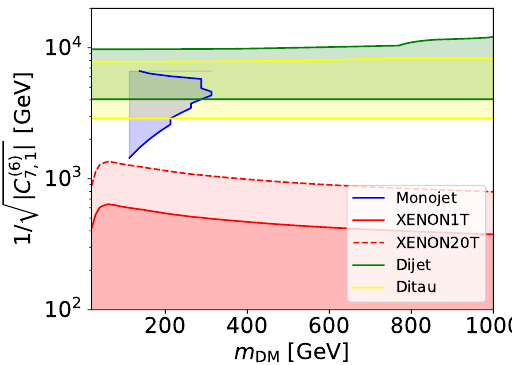
Figure 4. Exclusion limits for the model of table 1 from XENON experiment for 1 ton × year exposure (red solid) and for 20 ton × year exposure (red dashed), from LHC monojet (blue) and dijet (green) analyses with 139 fb − 1 integrated luminosity and ditau (yellow) analyses with 19 . 5 − 20 . 3 fb − 1 integrated luminosity. The results are shown in the plane with the DM mass on the x axis and the inverse of the square root of the Wilson coefficient | C (6) | on the y 7 , 1